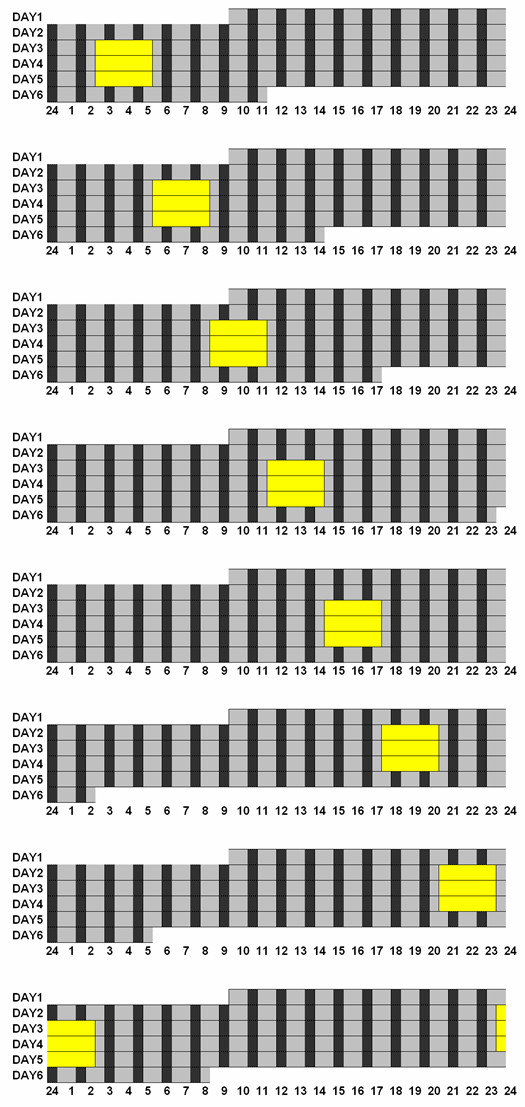
The experimental protocols. The experimental protocols are shown with an ordinate of 1 line per day and an abscissa of 24 h from midnight to midnight. Volunteers arrived in the laboratory at 09:30 on day 1. The ultra-short sleep-wake cycle, consisting of 30 min for sleep (black bars) followed by 60 min for wake (shaded bars) began at 10:30 and continued for 4.7 to 5.6 days. Three consecutive treatments (3 h bright light, yellow areas) were commenced after 38–54 h of baseline at one of 8 times. Circadian phase was assessed during the final 24 h of baseline preceding the first experimental treatment and for 24 h starting 6 h after the last treatment.